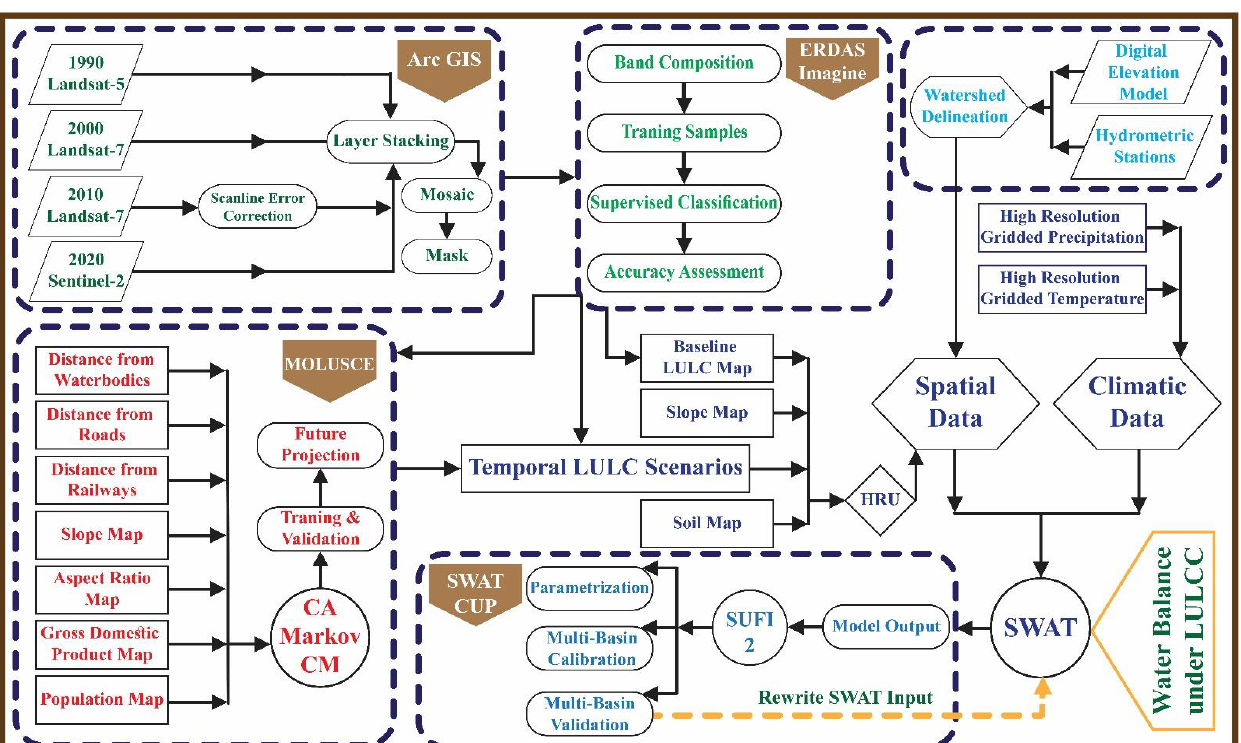
Figure 3. Methodological framework of the study.